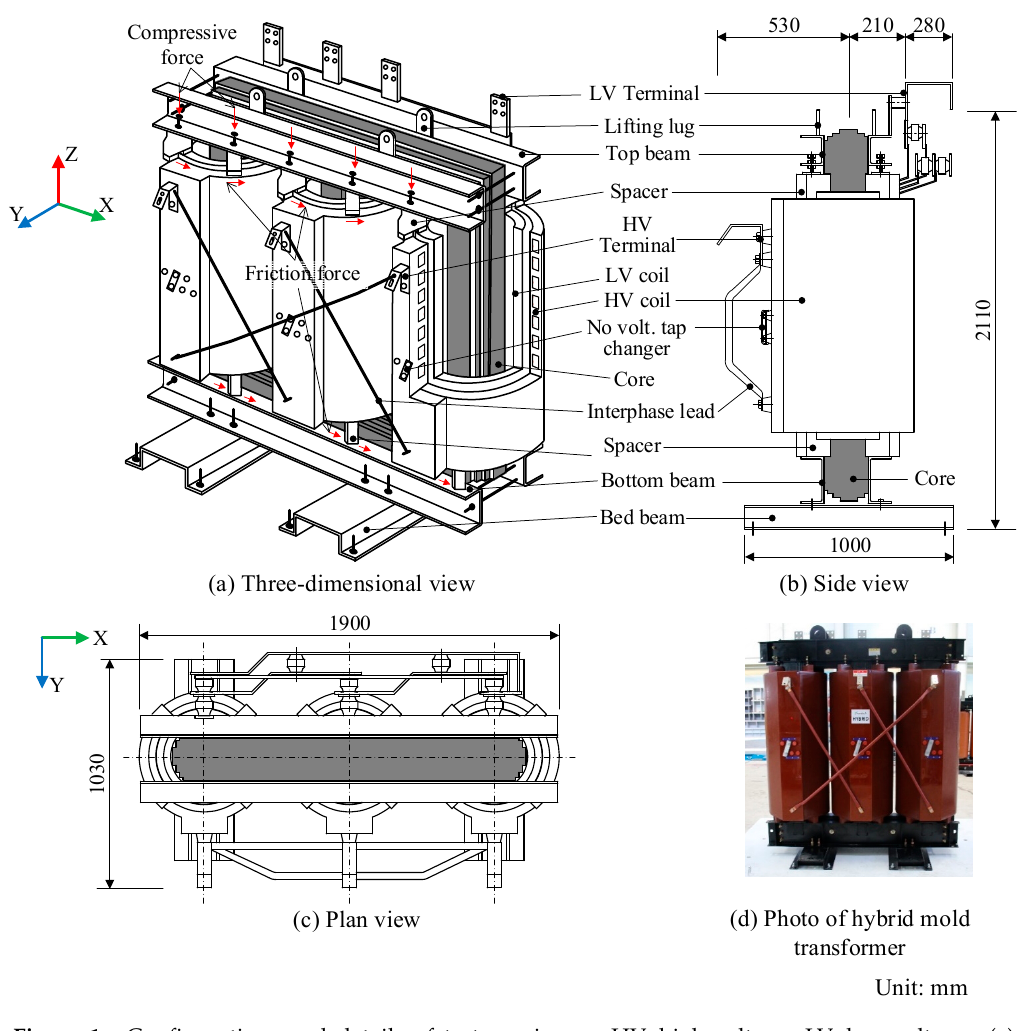
Figure 1. Configurations and details of test specimen. HV, high-voltage; LV, low-voltage: ( a ) Three-dimentional view; ( b ) Side view; ( c ) Plan view; ( d ) Photo of hybrid mold transformer. Table 2. Detailed specifications of the shaking table used in this test. Table Size (m ×